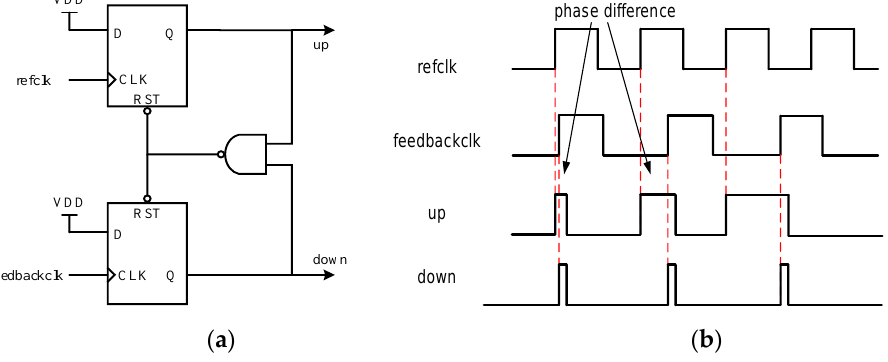
Figure 5. Traditional phase detector: ( a ) Architecture; ( b ) Timing waveform.